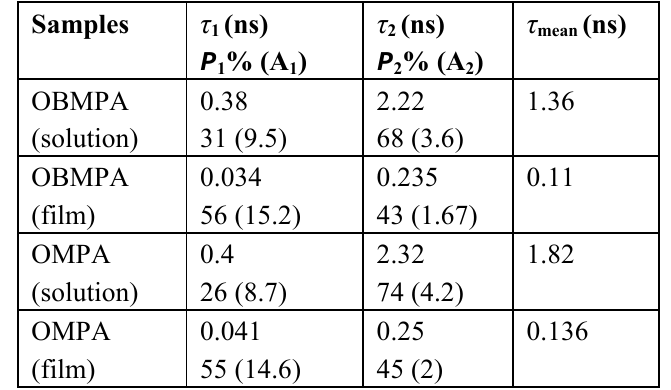
, τ , τ ), the pre-exponential factor ( A 1 2 mean and P to emission levels 1 and 1 2